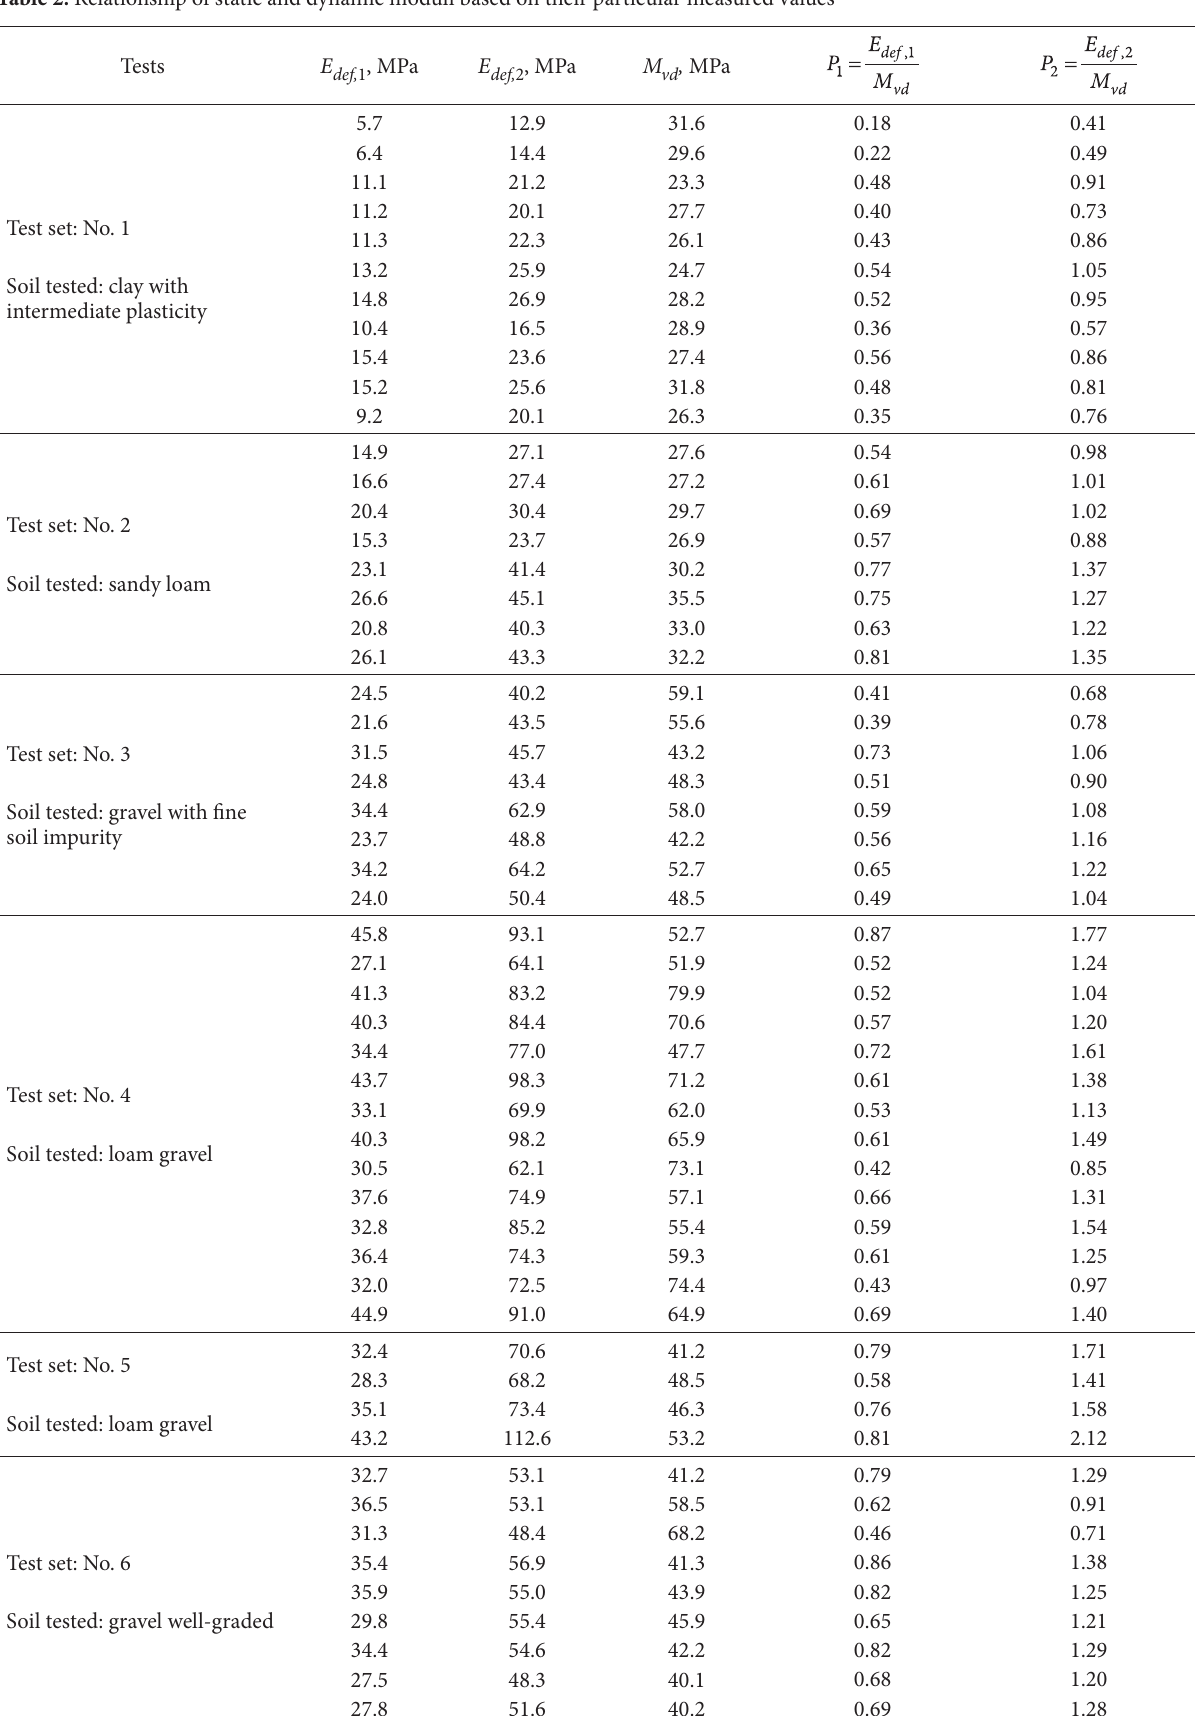
table 2. Relationship of static and dynamic moduli based on their particular measured values Tests E def, 1 , MPa E def, 2 , MPa M vd ,